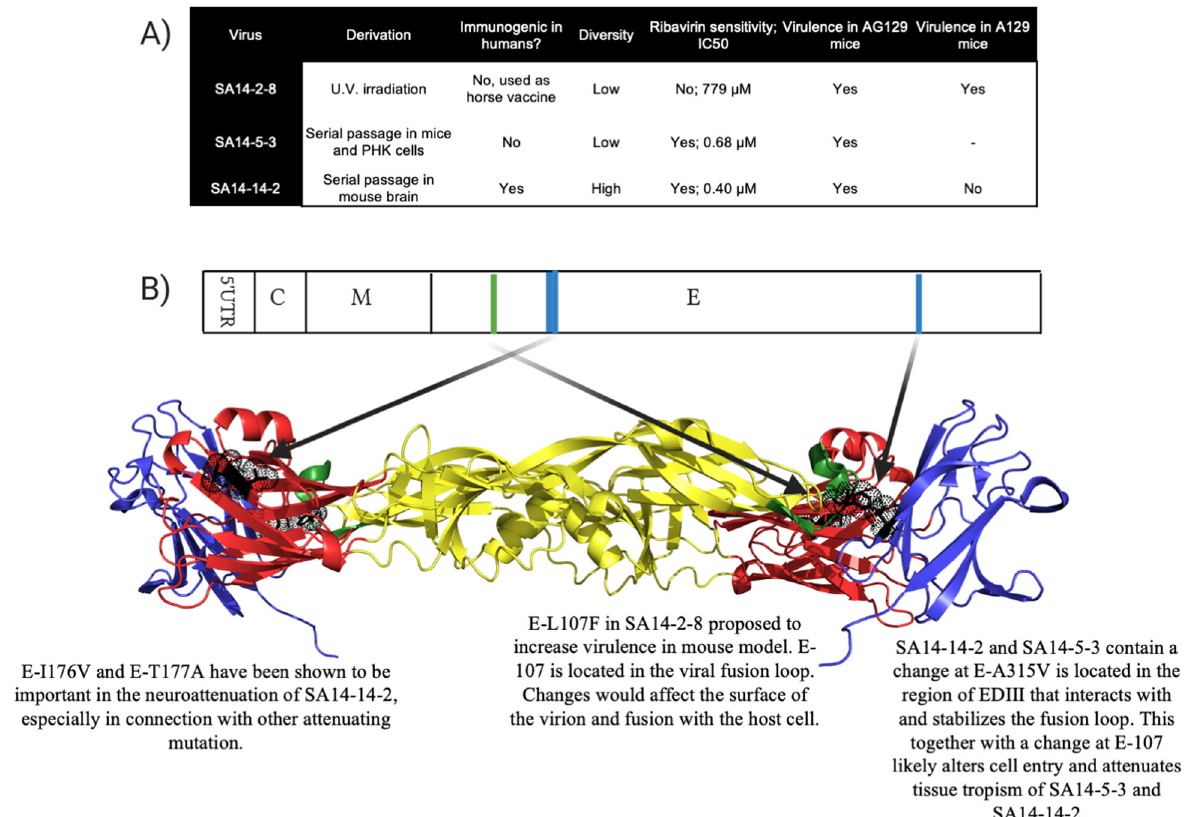
Fig. 7 Summary of attenuating E protein mutations in JEV vaccine strains. The three attenuated vaccine strains were empirically derived which led to distinct combinations of genotypes and phenotypes ( A ). It is apparent that genetic diversity doesn ’ t correlate with attenuation in mice. It is proposed that changes to the E protein of SA14-2-8 (shown in green) and SA14-14-2 (shown in blue) are responsible for differences in mouse virulence ( B